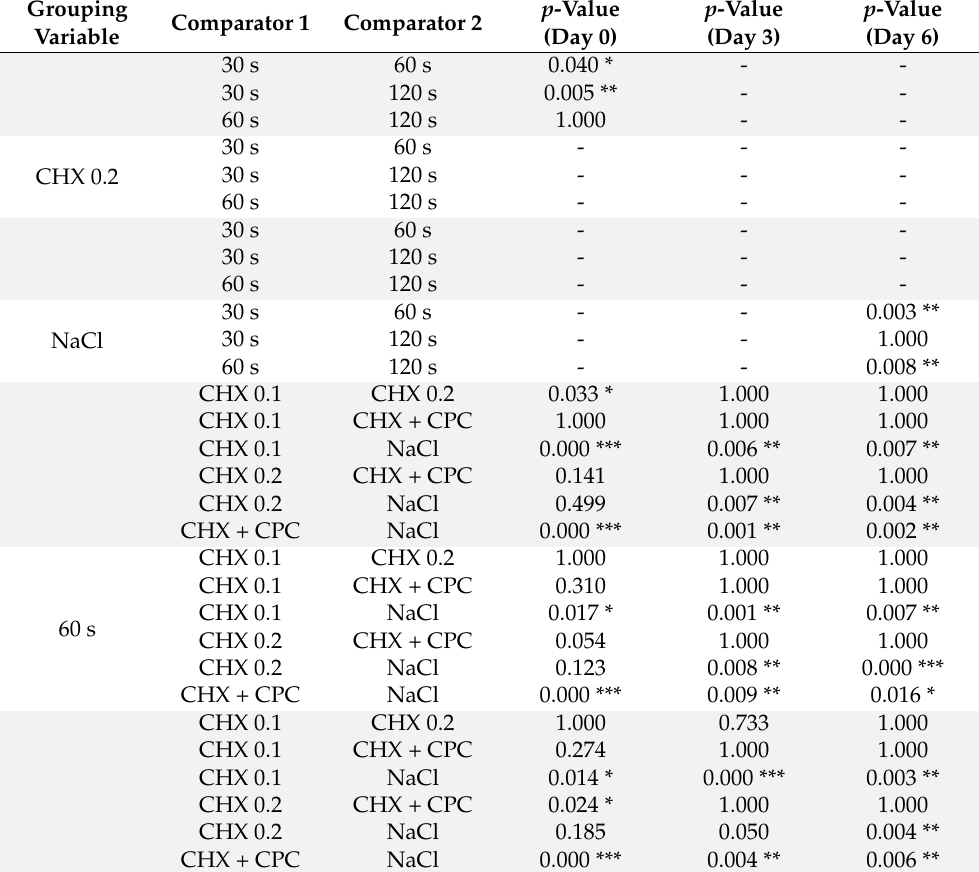
Table 1. Cell viability. A multiple Kruskal-Wallis test was performed to compare the groups at each time point (i.e., at day 0, 3 and 6), and in the case of significance, a post hoc multiple comparison test with Bonferroni p -value adjustment was performed. The adjusted p -values from post hoc test are reported and labeled as follows: * p < 0.05, ** p < 0.01, *** p <